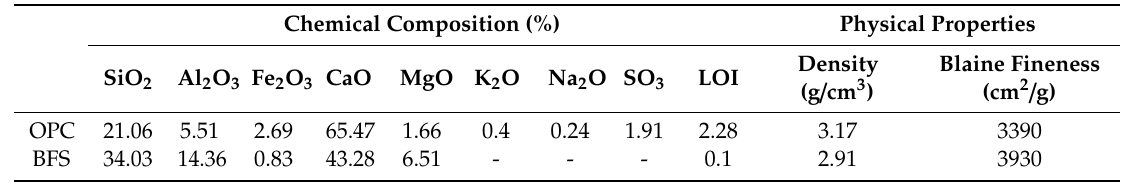
Table 1. Chemical and physical properties of material.